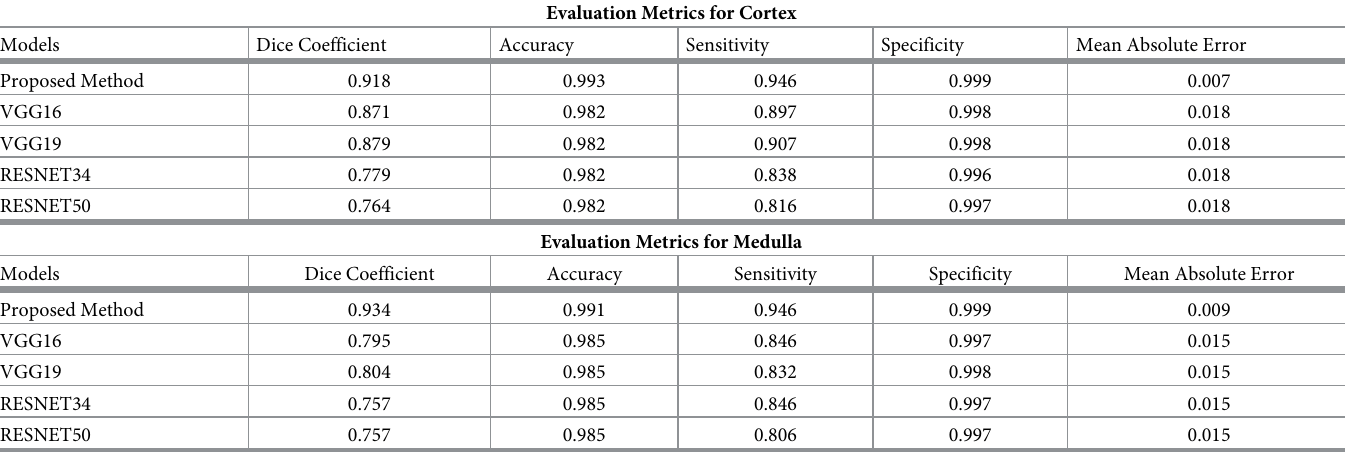
Table 2. Evaluation metrics comparison of the proposed RCM U-Net,VGG16 [15], VGG19 [17], ResNet34 [18], and ResNet50 [19], for cortex and medulla segmentation.